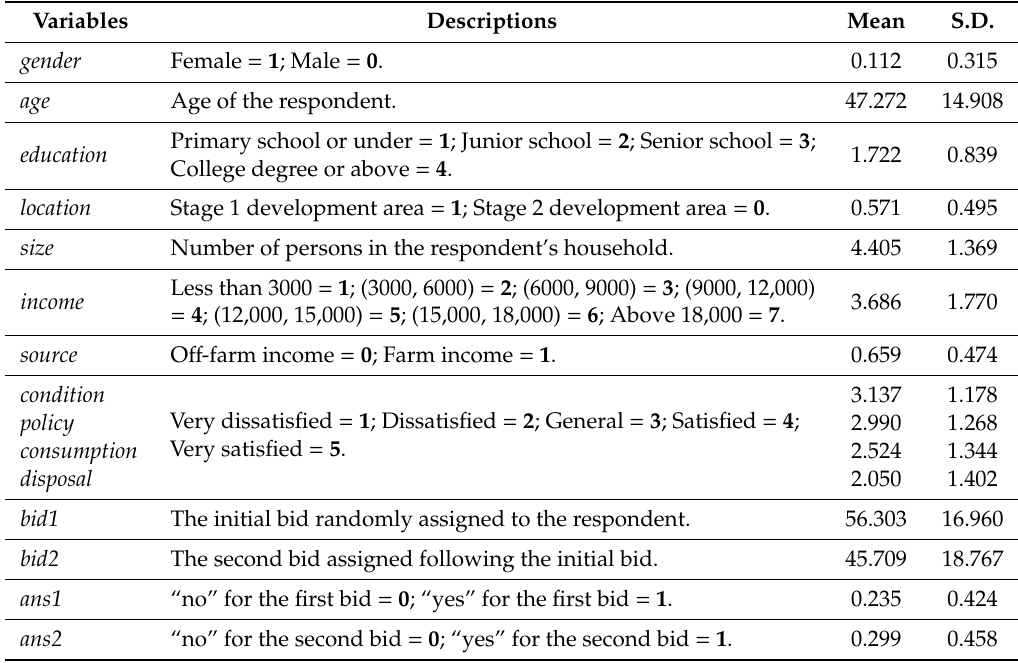
Table 1. Socioeconomic and choice characteristics of the